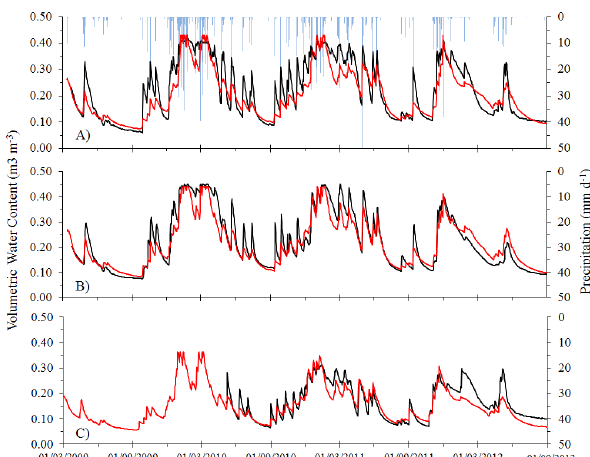
Figure 3: Observed and simulated soil moisture from March 2009 until September 2012. A) Site-1; B) Site-2; C) SMS-3. Black line are measured values, and red line are simulated values.